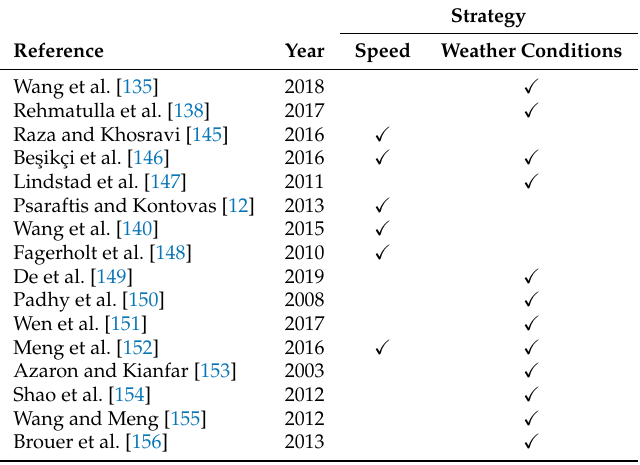
Table 6. Summary of energy saving strategies in maritime